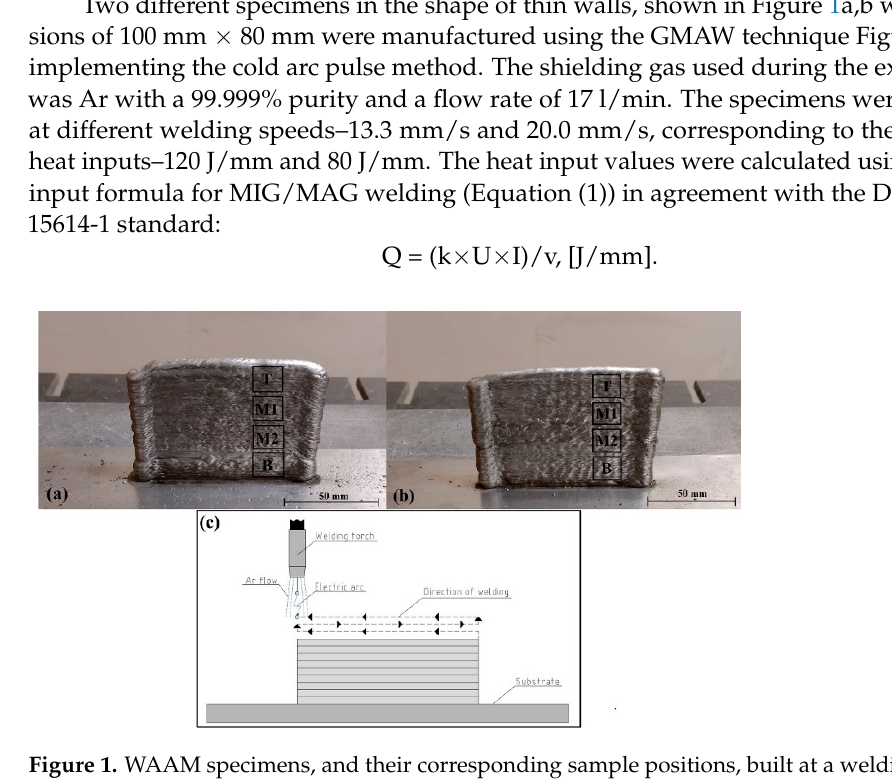
Table 1. Chemical composition of the substrate and the welding wire in wt%.